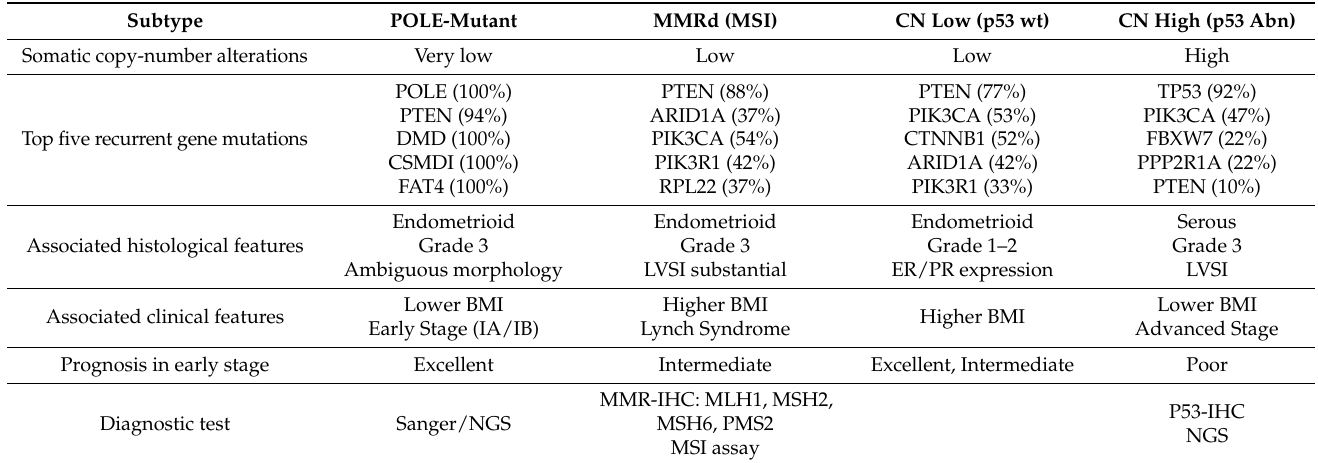
Table 2. Features of the four molecular subtypes. Adapted from